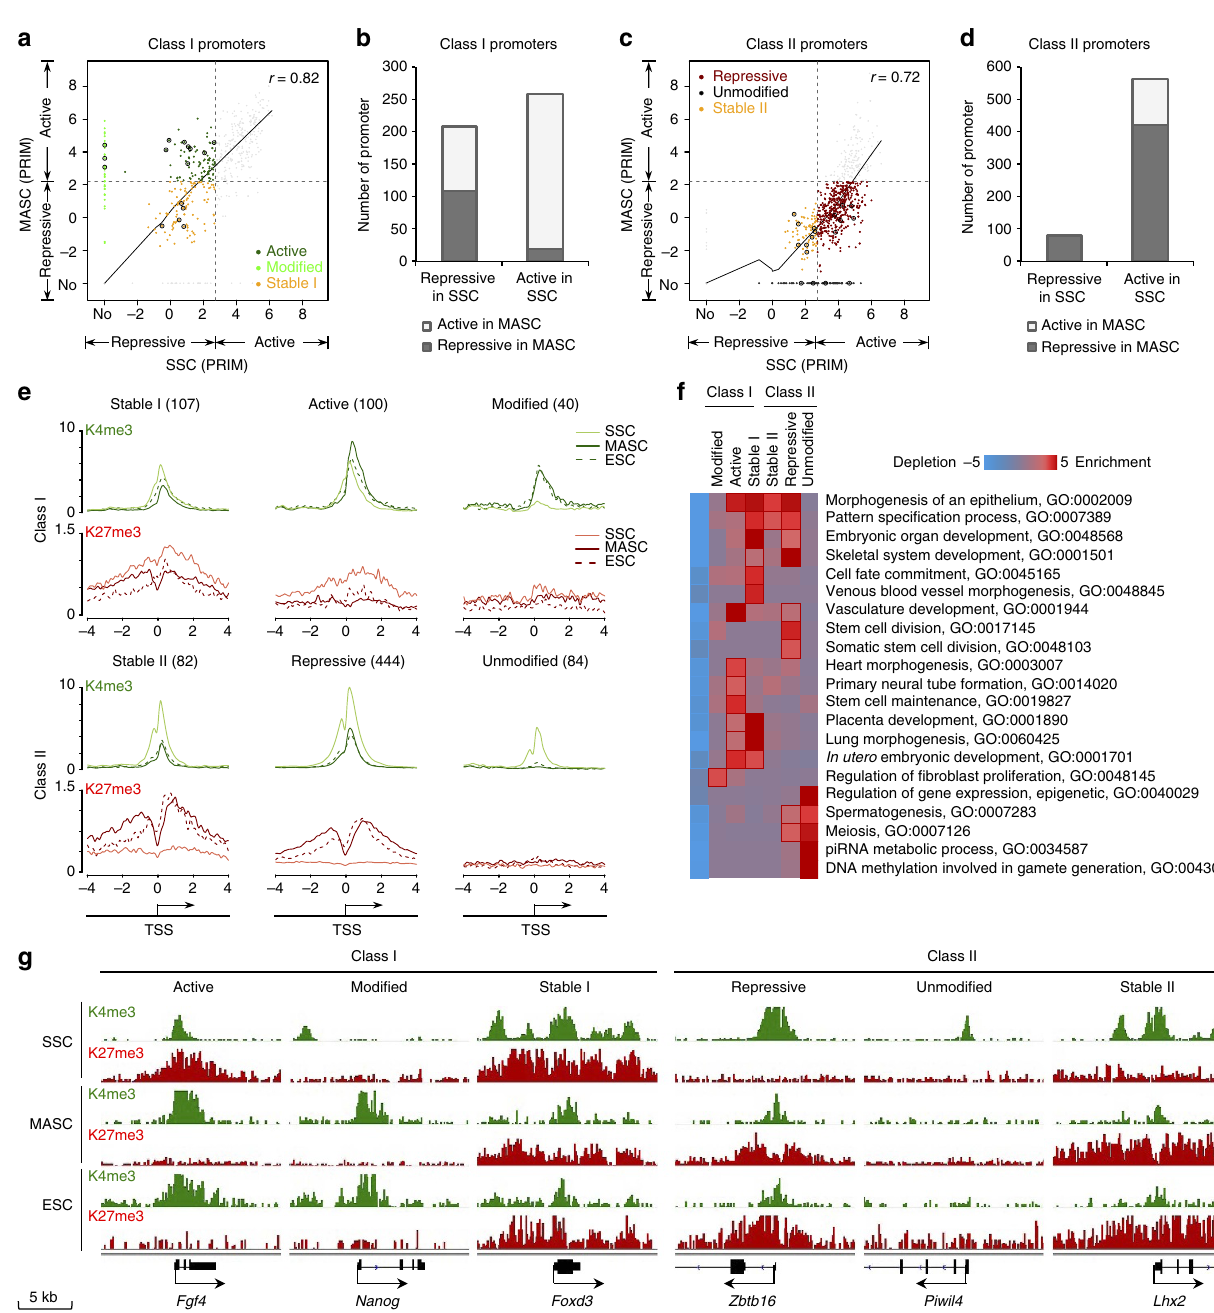
Figure 4 | Promoter chromatin states of differentially expressed genes are selectively changed. ( a ) Comparison of chromatin states (PRIMs) between SSCs and MASCs for all class I gene promoters (grey dots). x axis, PRIMs from SSCs; y axis, PRIMs from MASCs. Black circles, representative class I genes from Fig. 3a; dashed black line, cutoff between active and repressive chromatin states; dark grey line, optimal curve fits to all class I gene promoters. r , correlation coefficient with all class I gene promoter PRIMs. On the basis of the cutoff value, three groups of promoters were selected: MASC Active (dark green dots); MASC Modified (light green dots); and MASC Stable I (yellow dots). ( b ) Number of class I gene promoters changing between repressive and active chromatin states in SSCs and MASCs. Light grey, epigenetically active promoters in MASCs; dark grey, epigenetically repressive promoters in MASCs. ( c ) Comparison of chromatin states (PRIMs) between SSCs and MASCs for all class II gene promoters (grey dots). Black circles, representative class II from Fig. 3a; dark grey line, optimal curve fits to all class II gene promoters. r , correlation coefficient with all class II gene promoter PRIMs. On the basis of the cutoff value, three groups of promoters were selected: MASC Repressive (dark red dots); MASC Unmodified (black dots); and MASC Stable II (yellow dots). ( d ) Number of class II gene promoters changing between repressive and active chromatin states in SSCs and MASCs. Light grey, epigenetically active promoters in MASCs; dark grey, epigenetically repressive promoters in MASCs. ( e ) Histone modification enrichment profiling for selected class I gene promoters (top) and class II gene promoters (bottom) (grouped as in a , c ). Number in brackets, gene number in each group. Green, K4me3; red, K27me3; solid light line, SSCs; solid dark line, MASCs; dashed dark line, ESCs; arrow, direction of transcription; x axis, distance to TSS; y axis, average read density. TSS, transcription start site. ( f ) GO enrichment in selected genes. Genes are grouped by promoter PRIMs as in a and c . ( g ) Promoter modification at selected genes. Top, expression class and promoter type of each gene; green, K4me3; red, K27me3. K4me3 track range, 0–1; K27me3 track range,